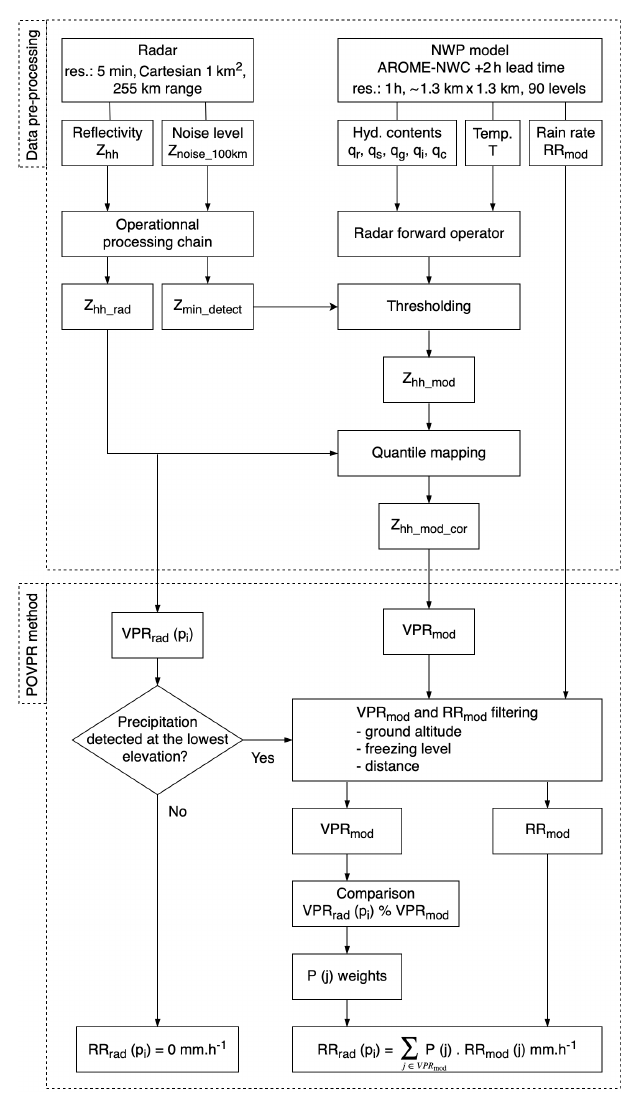
Figure 3. Process flow chart of the data pre-processing and the POVPR method for computing a pixel-wise ground rain rate from observed and simulated